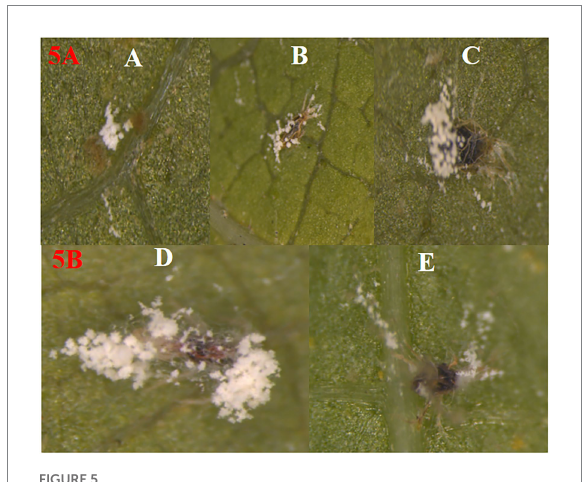
FIGURE 5 (5A) Effect of B. bassiana at all growth stages of T. truncatus. Mortality of T. truncatus at different growth stages due to B. bassiana infection (A) egg, (B) nymph, (C) adult. (5B) Growth and sporulation differences of (D) potential (Bb6) and (E) non potential (Bb23) isolates of B. bassiana . on T. truncatus.